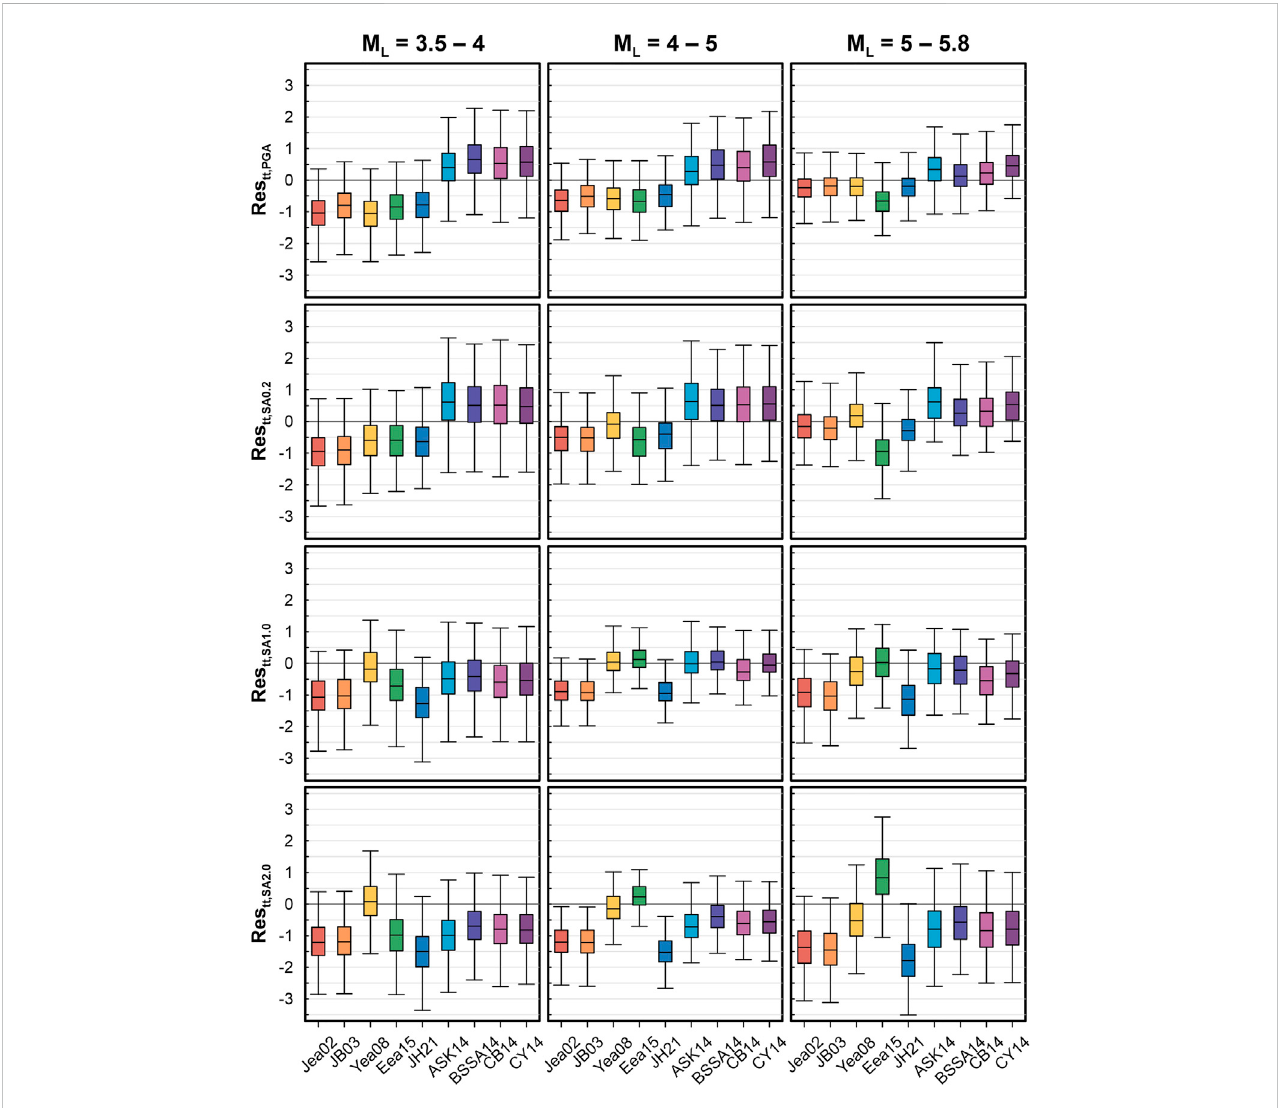
FIGURE 4 Total residual boxplots of four IMs (PGA, SA 0.2 , SA 1.0 , and SA 2.0 ) binned by M L for nine